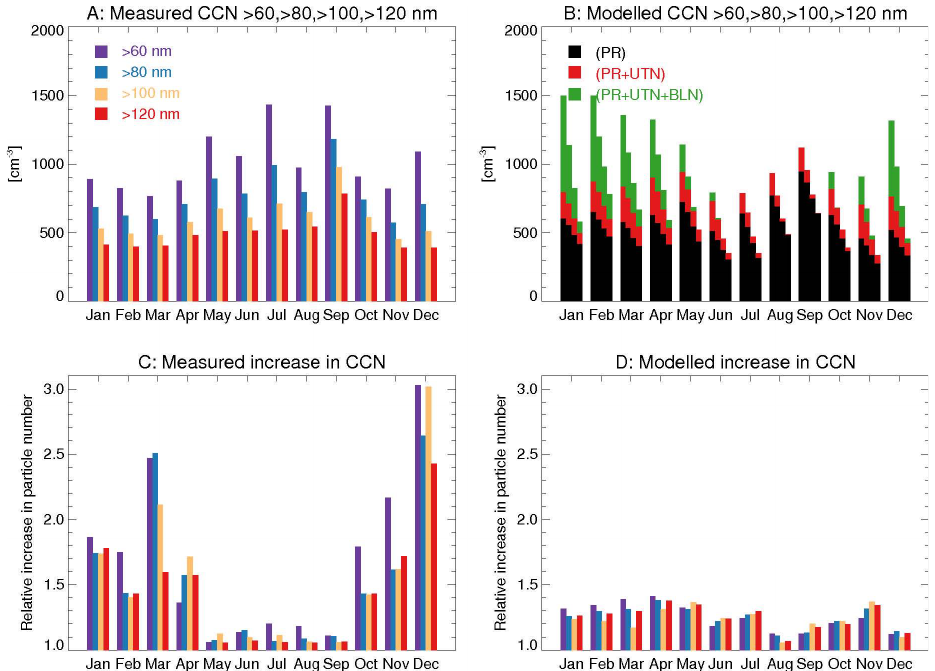
Fig. 8. (A) Measured monthly median concentration of particles above 60nm, 80nm, 100nm and 120nm; (B) Modelled monthly median concentration of particles above 60nm, 80nm, 100nm and 120nm using kinetic sulphuric acid nucleation (Eq. 1) and the standard secondary organics scheme; (C) Observed relative increase of CCN-sized particles (median); and (D) Simulated relative increase of CCN-sized particles with kinetic sulphuric acid nucleation and the standard secondary organics (median).